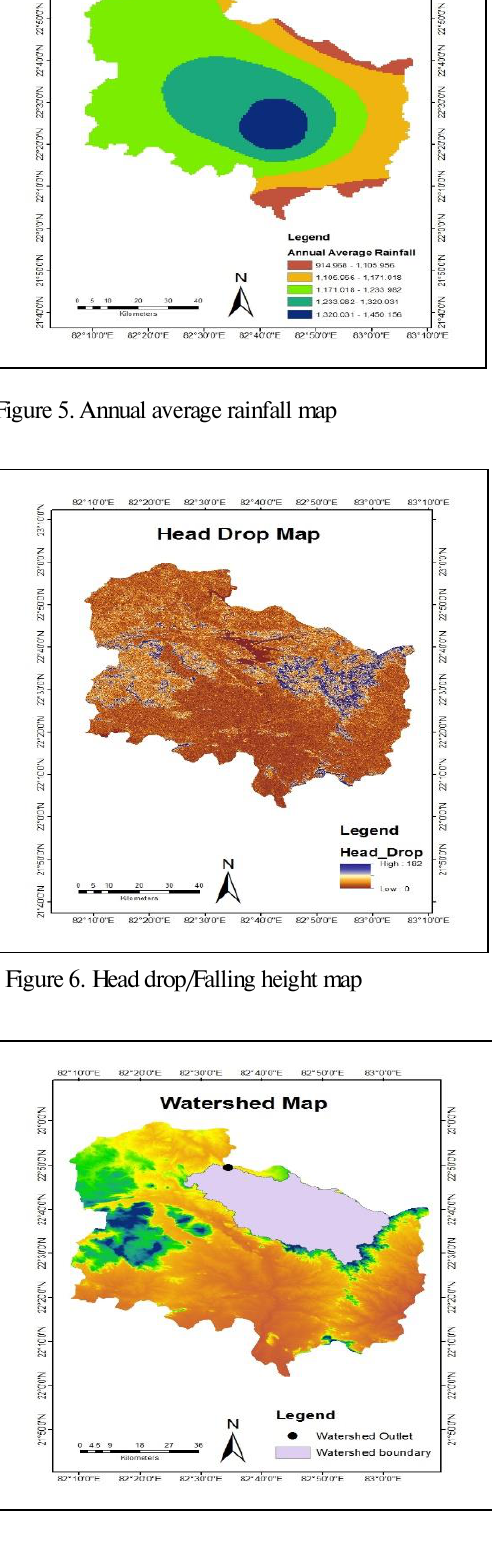
Figure 4. Curve number (CN II) map